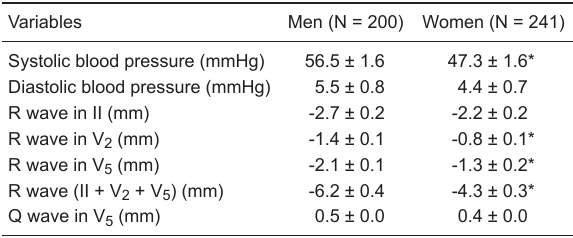
Table 5. Differences between baseline and peak exercise in blood pressure, R wave amplitude and Q wave amplitude in men and